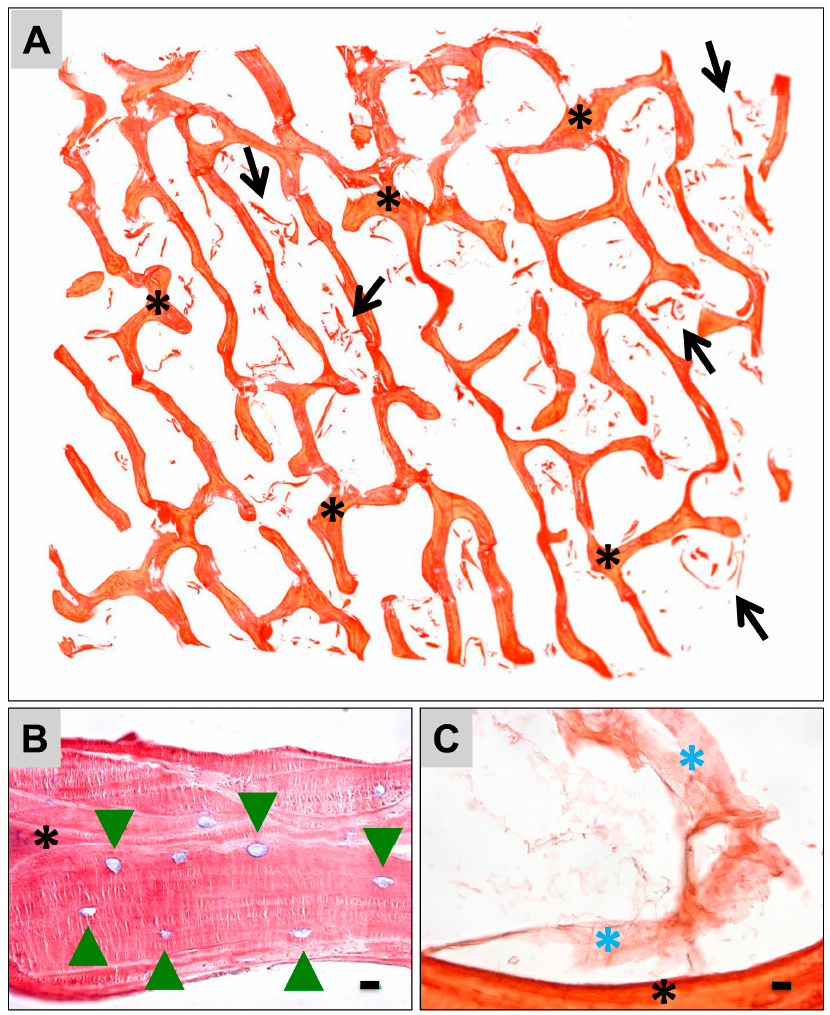
Figure 3. Representative histological images of the ultrastructure of the xenogeneic SMARTBONE ® bone block. ( A ) The bone block shows a trabecular structure (asterisks = trabeculae). Within the trabecular interspaces, high numbers of matrix fragments were overserved (arrows) (Sirius red-staining, “total scan”, 10× magnification). ( B ) SMARTBONE ® shows a lamellar bone matrix organization. No signs of cells or cell remnants were detected within the osteocyte lacunae (green arrow heads) nor adherent to the outer surfaces of the bone matrix (Giemsa staining, 40× magnification, scale bar = 10 µm). ( C ) Within the trabecular interspaces (black asterisk = trabecula) collagenous structures (blue asterisks) were identifiable (Sirius red staining, 60× magnification, scale bar = 1 µm). Table 1. Revised classification of available natural blocks for bone